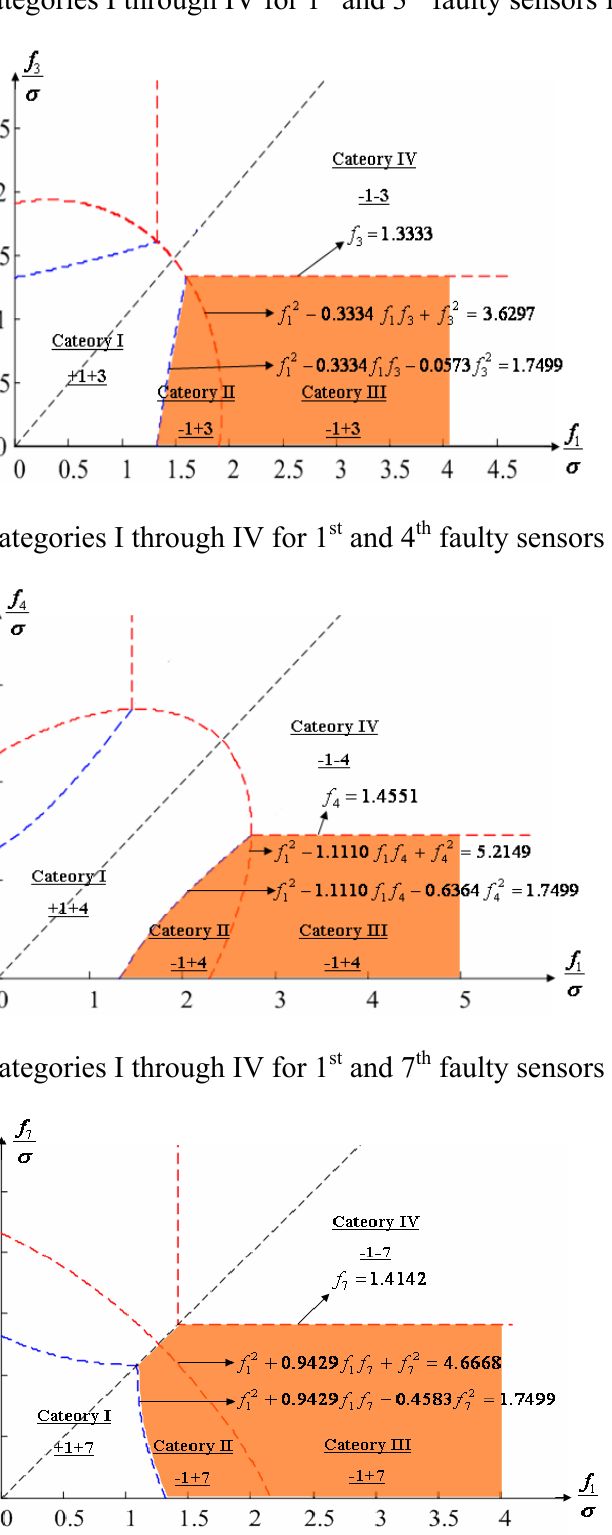
Figure 9. Region of categories I through IV for 1 st and 3 rd faulty sensors for configuration 2.